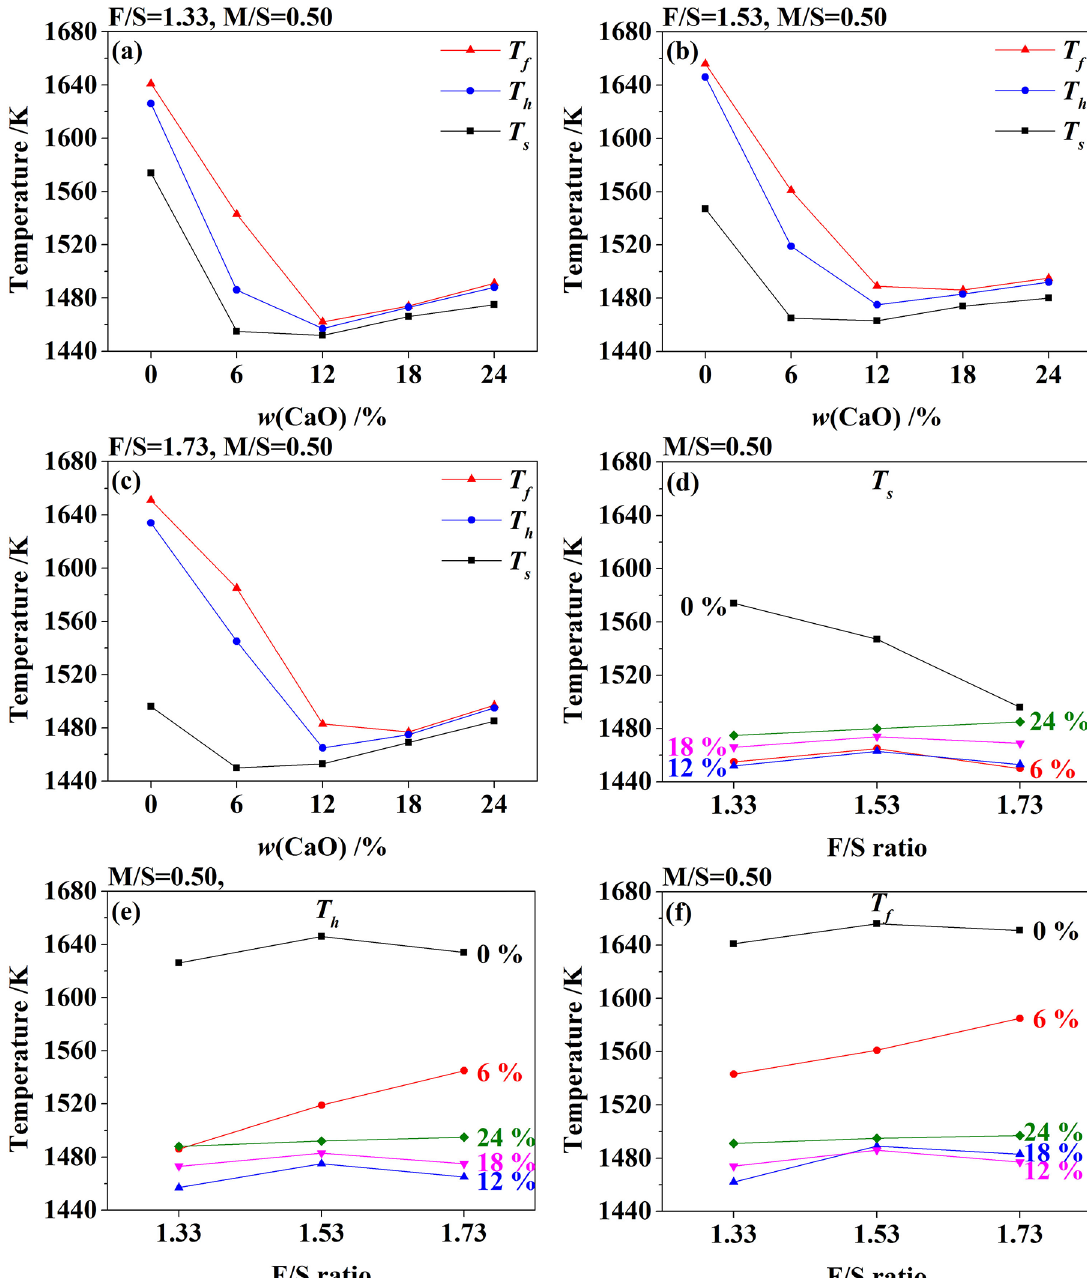
Figure 2. Influence of F/S and w (CaO) on the measured characteristic